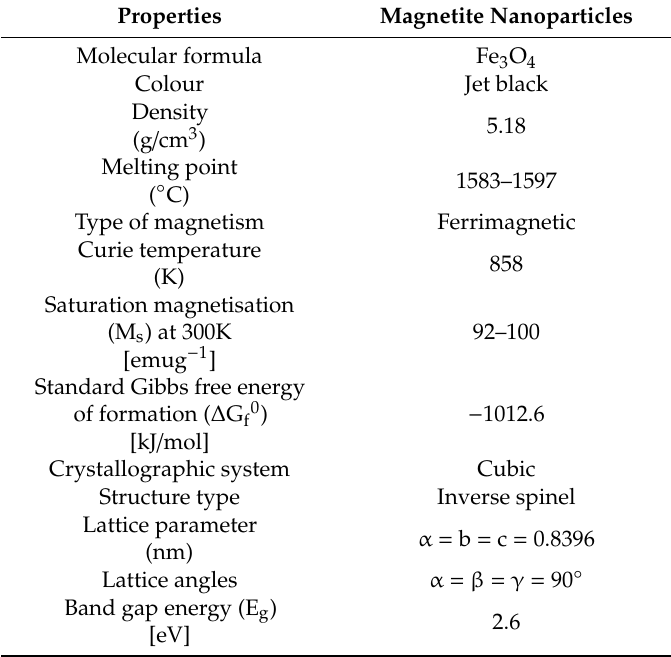
Table 2. Summary of the properties of magnetite nanoparticles